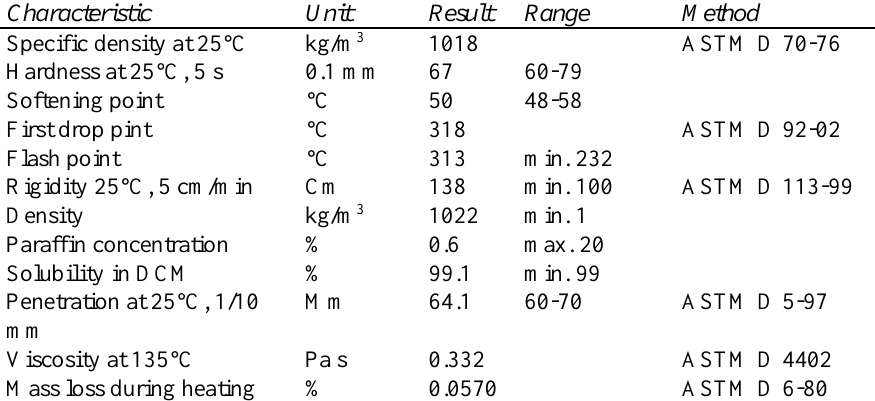
Table 2. Physicochemical and mechanical properties of bitumen.